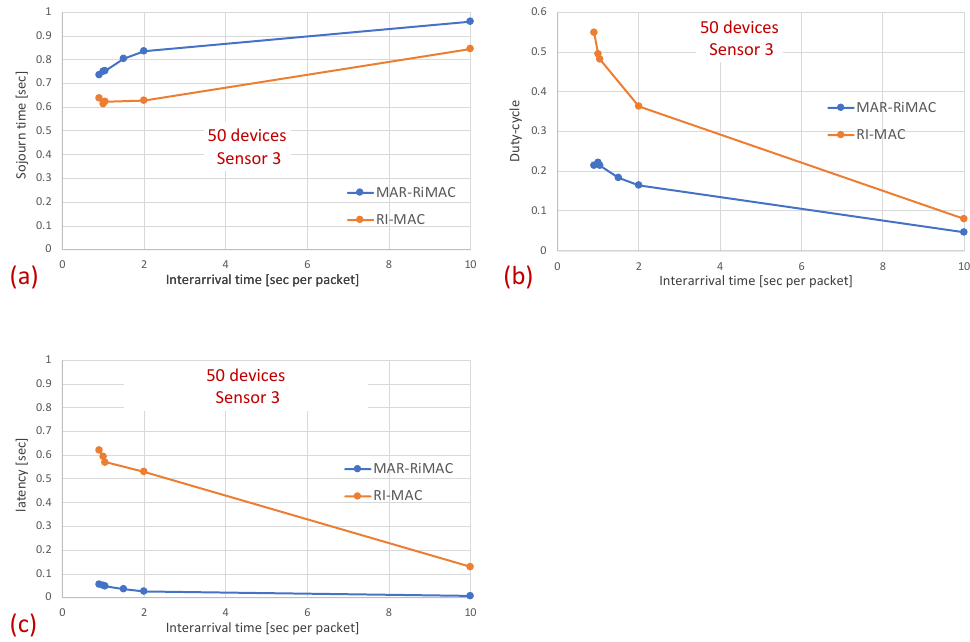
Figure 16. Hidden-terminal topology: The performance of a specific device (Device 3) for a topology comprising 50 devices under various mean inter-arrival times ( λ ). ( a ) Sojourn time. ( b ) Duty cycle. ( c ) Latency because both the transmitting device and the sink are